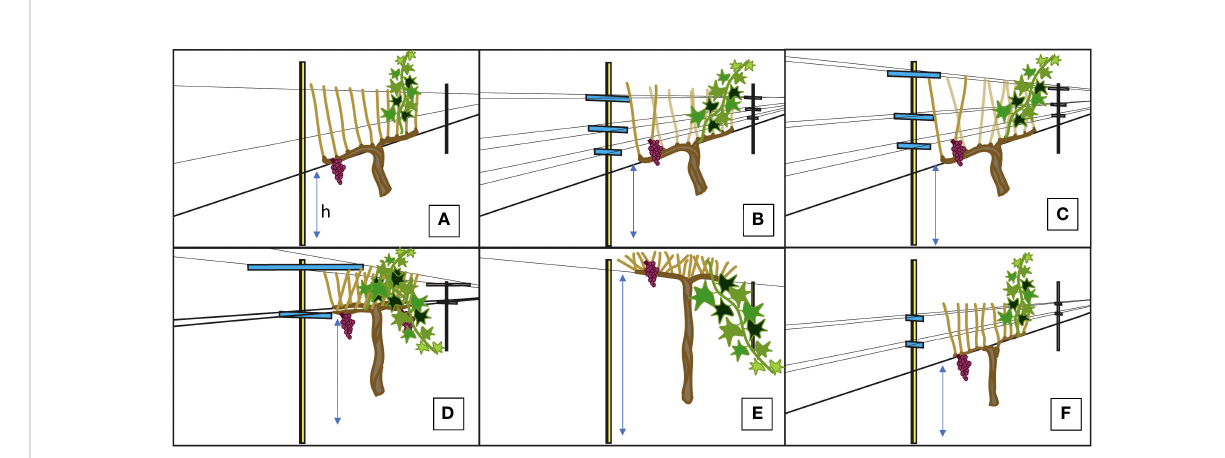
FIGURE 1 Illustrations for the Trellis Systems Established at the Oakville Experimental Vineyard: (A) Traditional Vertical Shoot Position (VSP); (B) Vertical Shoot Position 60 ° (VSP60); (C) Vertical Shoot Position 80 ° (VSP80); (D) High-Quadrilateral (HQ); (E) Single High Wire (SH); (F) Guyot-pruned Vertical Shoot Position (GY). “ h ” stands for the cordon height from the vineyard ground and the h for each trellis system was described in Materials and